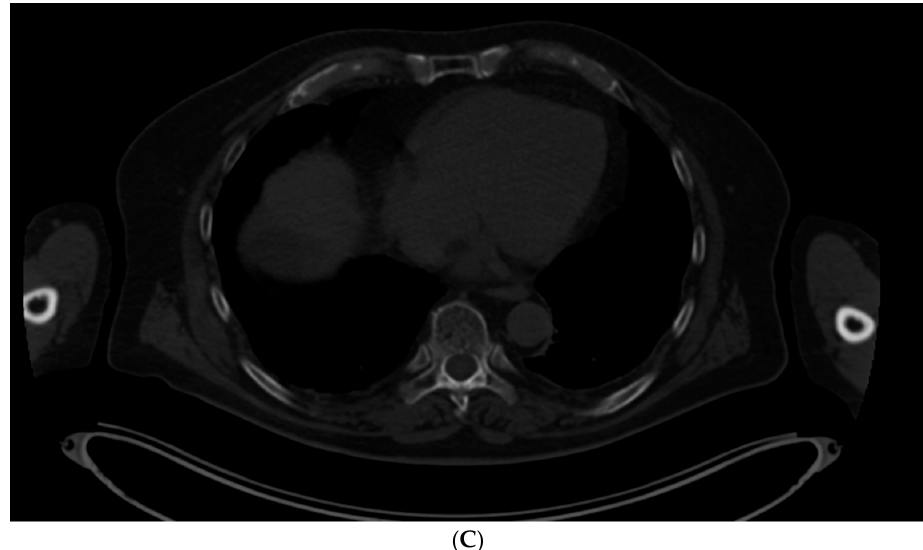
Figure 2. IgAk SMM patient with only one focal lesion of a thoracic vertebral body (maximum standardized uptake value (SUVmax): 15.34) depicted in FDG-PET/CT. ( A : Positron emission tomography (PET) slice and B : PET/CT fused slice). Because of the absence of osteolytic lesions on the opposite CT ( C ), biopsy was performed in this area, revealing a focal monotype k accumulation of